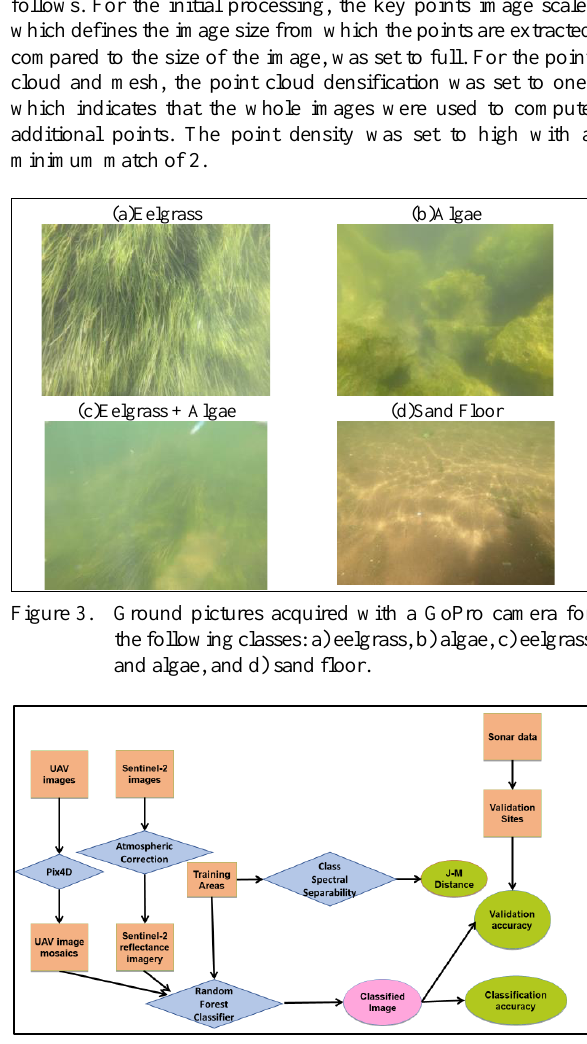
Figure 4. Flowchart presenting the methodology used for processing both the Sentinel-2 and UAV images.